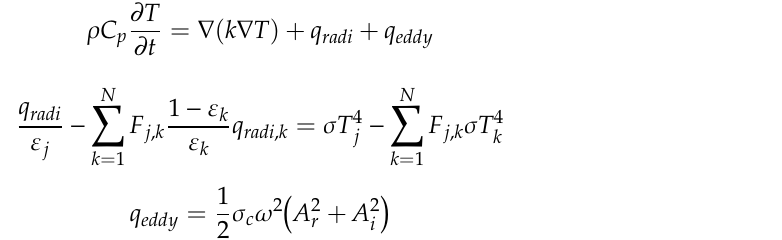
Table 1. Thermophysical properties of materials in the growth